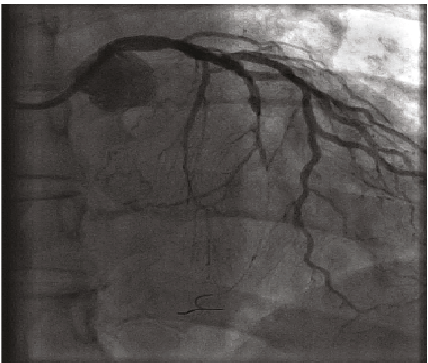
Figure 2: Occlusion of the middle segment of the left circum fl ex artery (LCx) (image after a partial recanalization with a guidewire).